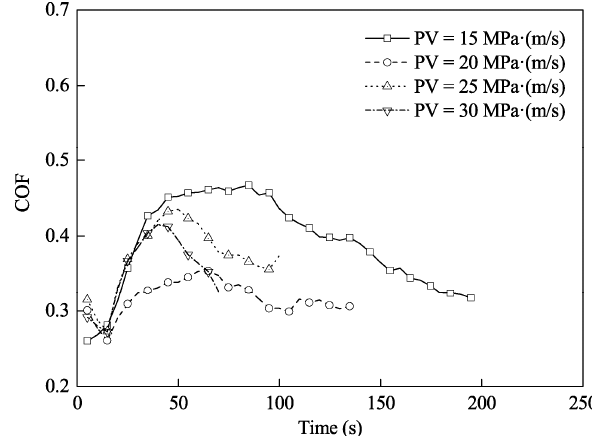
Fig. 11 COFs with the copper–chromium alloy disk under the water-lubricated